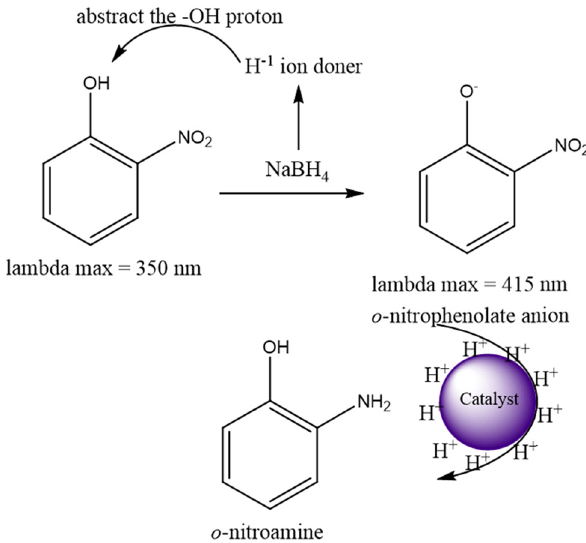
Scheme 1: Pictorial representation for the reduction of ONP in the presence of NaBH 4 as a reductant and CuNi@CP